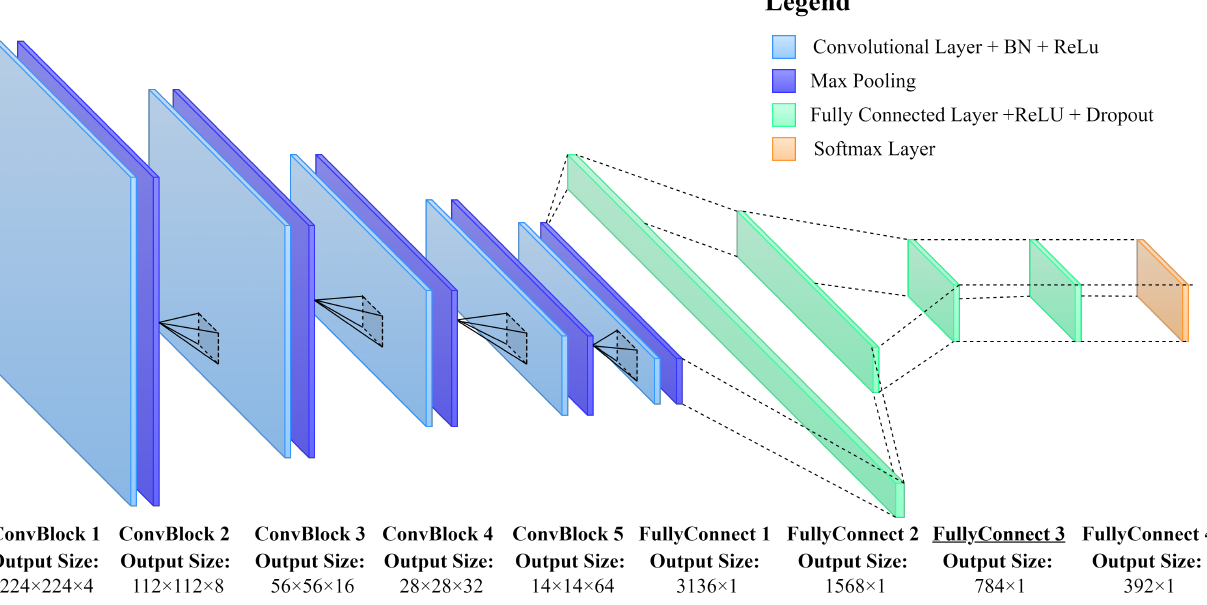
Figure 5. Configuration of the proposed CNN